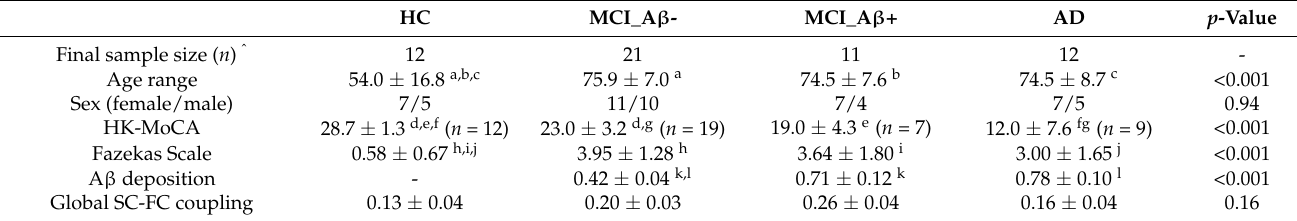
Table 1. Demographic and clinical characteristics of healthy controls and patients with mild cognitive impairment or Alzheimer’s